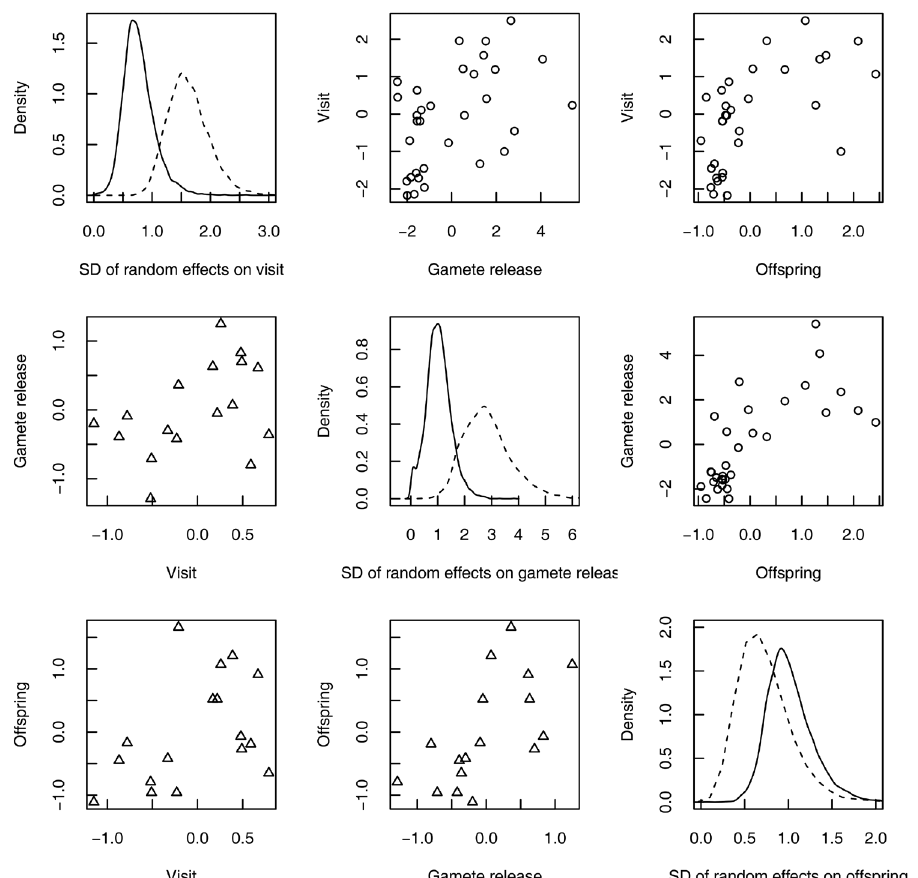
Figure 3. Random individual effects on the probability of visit, the probability of gamete release and the number of offspring produced by brown trout on each mating occasion. The diagonal indicates the posterior probability distribution of the standard deviation of the Gaussian distribution in which random effects for the three components of reproductive success were drawn (dashed and solid lines are for females and males, respectively). Plots above the diagonal show the pairwise relations between random individual effects on each process, for females (one circle per female). Plots below the diagonal show the same thing for males (one triangle per